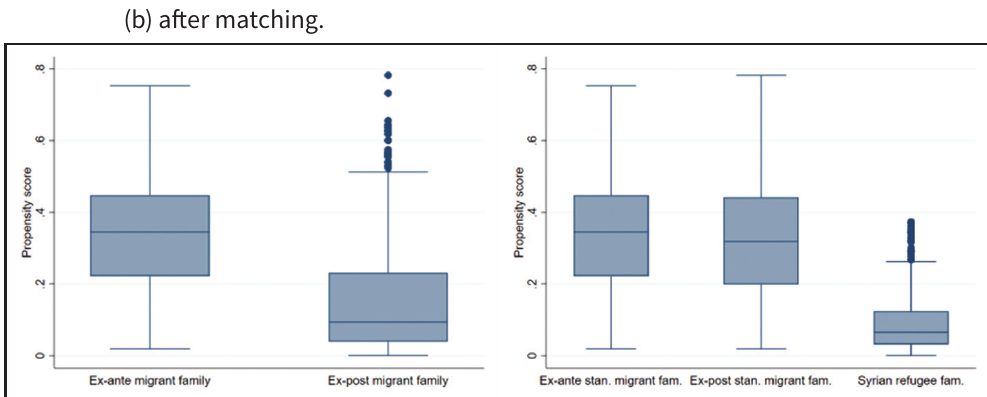
Figure 2 Propensity scores, before and after matching: (a) before matching and (b) after matching.